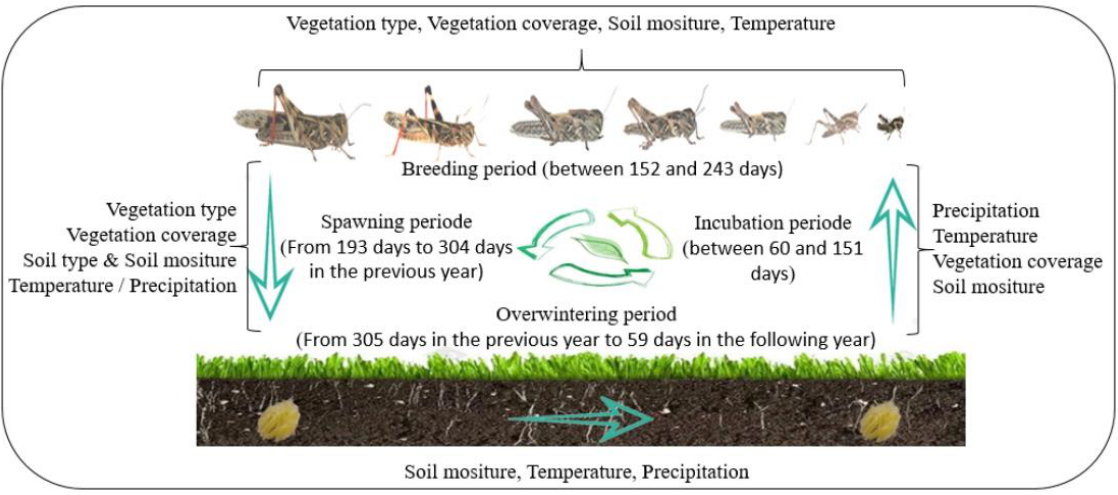
Figure 2. Life cycle of grasshoppers and major influencing factors.